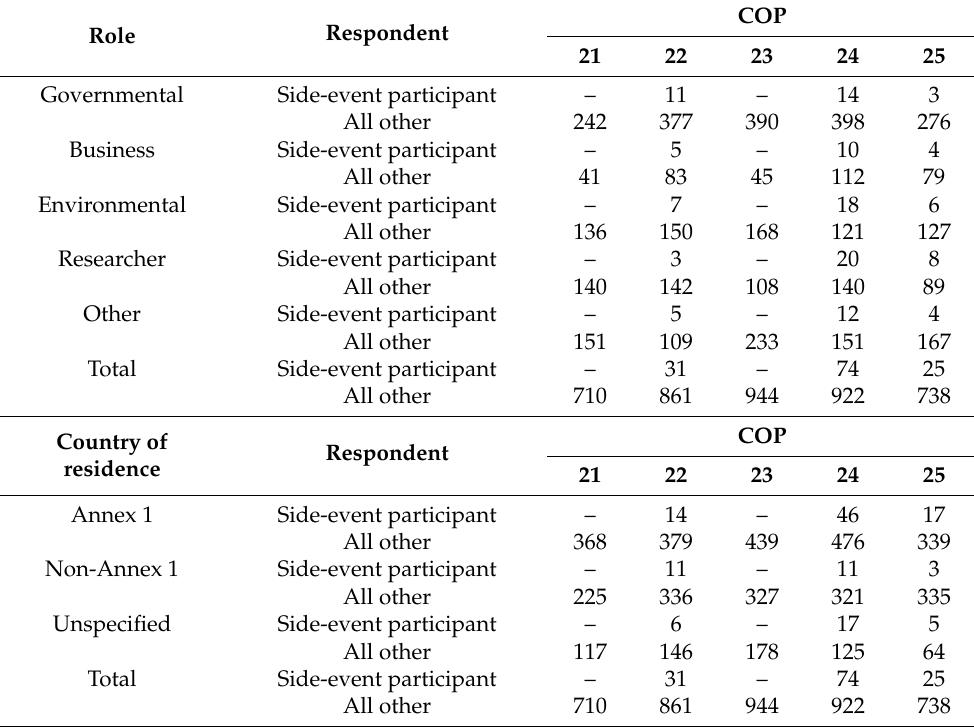
Table 1. Number of respondents surveyed inside and outside the CCS side-event at each COP by primary role and country of residence. Note that the questionnaire was only given at the official UNFCCC side-event at COPs 22, 24, and